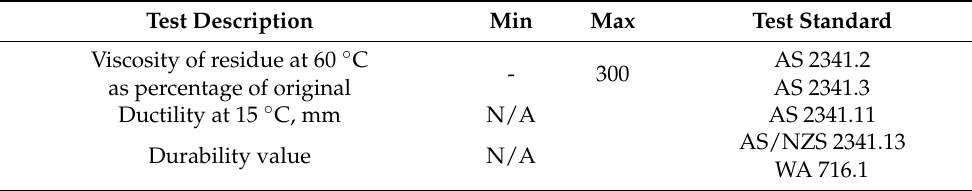
Table 4. Rolling thin film oven test: C320 AS